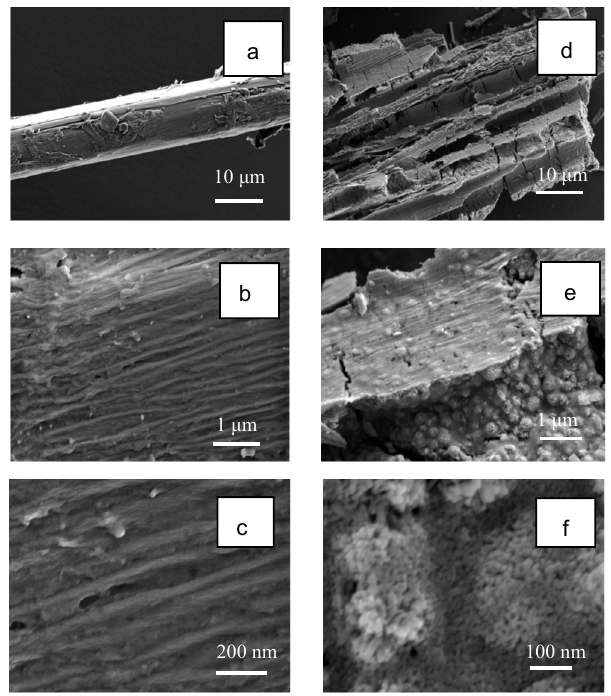
Figure 6. SEM images of the flax template ( a – c ) and fibrous TiO 2 600 ( d – f ).